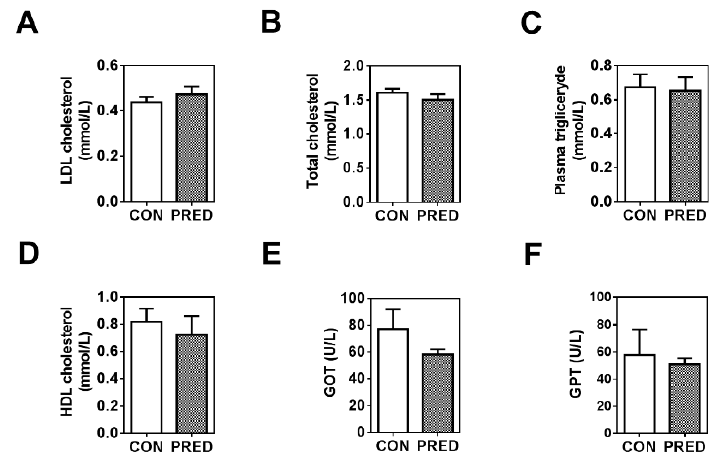
Figure 2. Plasma concentrations of lipids and liver enzymes. ( A ) LDL cholesterol (mmol/L), ( B ) total cholesterol (mmol/L), ( C ) plasma triglyceride (mmol/L), ( D ) HDL cholesterol (mmol/L), ( E ), glutamate oxaloacetate transaminase (GOT; U/L) and ( F ) glutamate pyruvate transaminase (GPT; U/L) concentrations in obese prediabetic (PRED, grey columns) and control (CON, white columns) rats at the end of the study. Data are means ± SEM, n = 11/group. Unpaired two-tailed Student’s t-test.